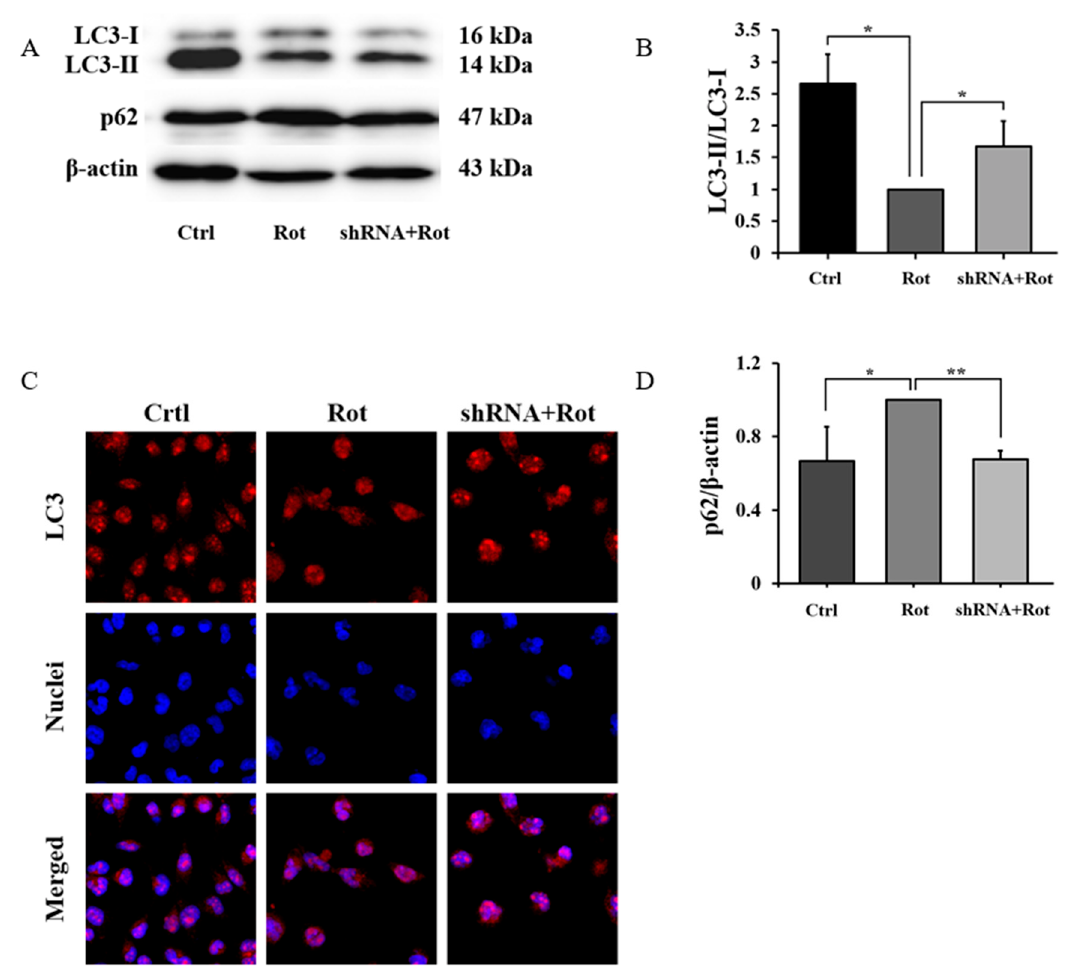
Figure 6. The knockdown of HDAC4 activated autophagy in SH-SY5Y cells. Levels of LC3 and p62 were detected through Western blot analysis. LC3B puncta within autophagosomes were identified using immunofluorescent staining. ( A , B , D ) Rotenone reduced the LC3- Ⅱ / LC3- Ⅰ ratio and increased p62 levels in SH-SY5Y cells, while HDAC4 downregulation induced an increase in LC3- Ⅱ / LC3- Ⅰ ratio and a decrease in p62 levels. ( C ) The knockdown of HDAC4 increased LC3B red fluorescent puncta, which were reduced with the treatment of rotenone in SH-SY5Y cells. * p < 0.05; ** p < 0.01. Ctrl., control. Rot., rotenone.